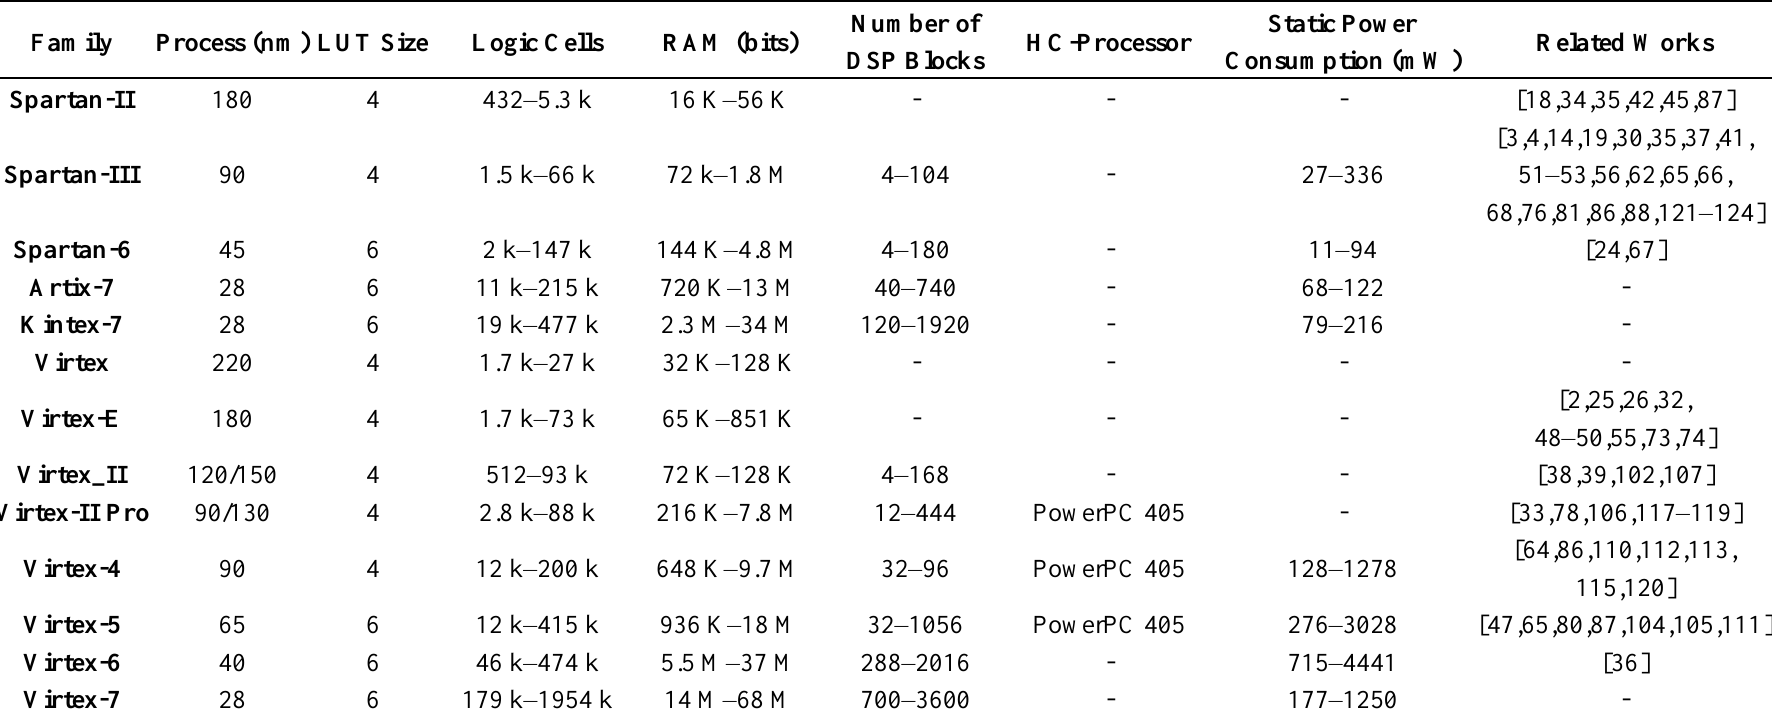
Table 1. Characteristics, static power consumption and related works of the different FPGA series of Xilinx